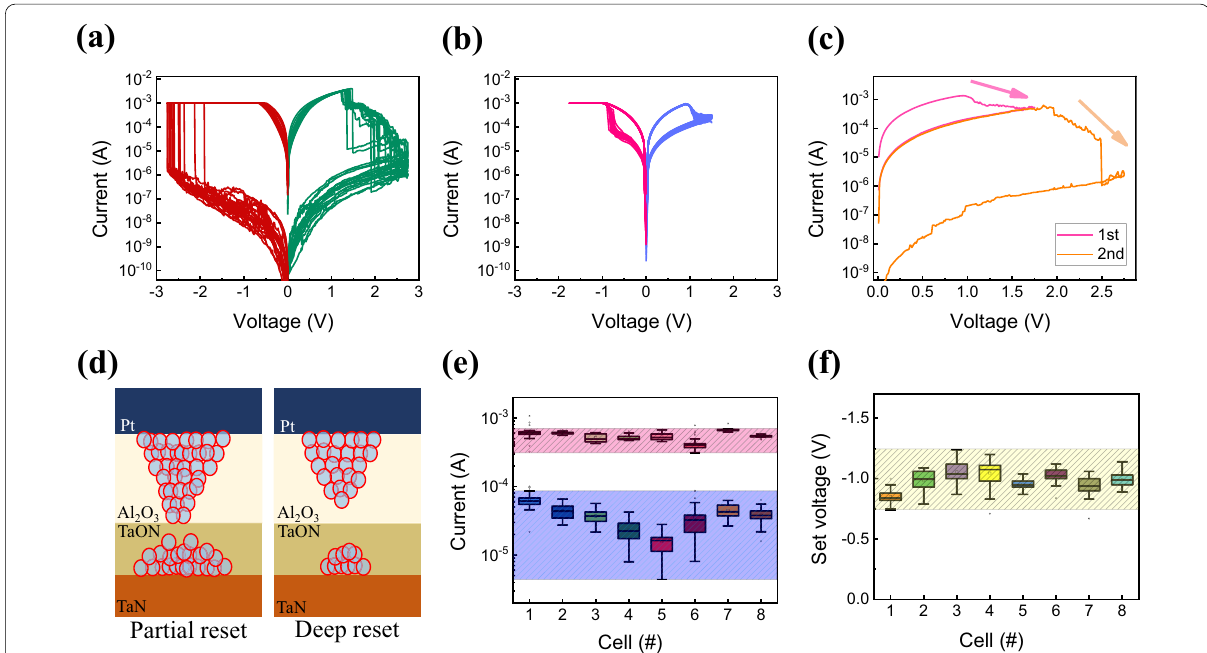
Fig. 3 Bipolar resistive switching of Pt/Al 2 O 3 /TaN device: a deep reset, b partial reset, c process of inducing from partial reset to deep reset, and d deep and partial reset mechanism schematic diagram. Uniformity of e HRS and LRS, f set